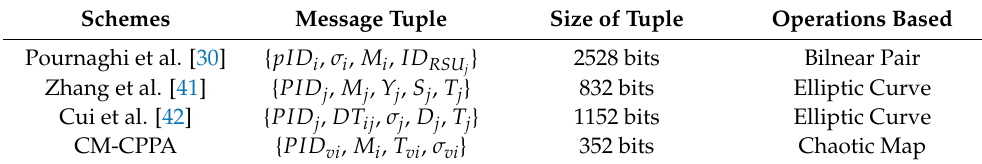
Table 4. Comparison of Communication